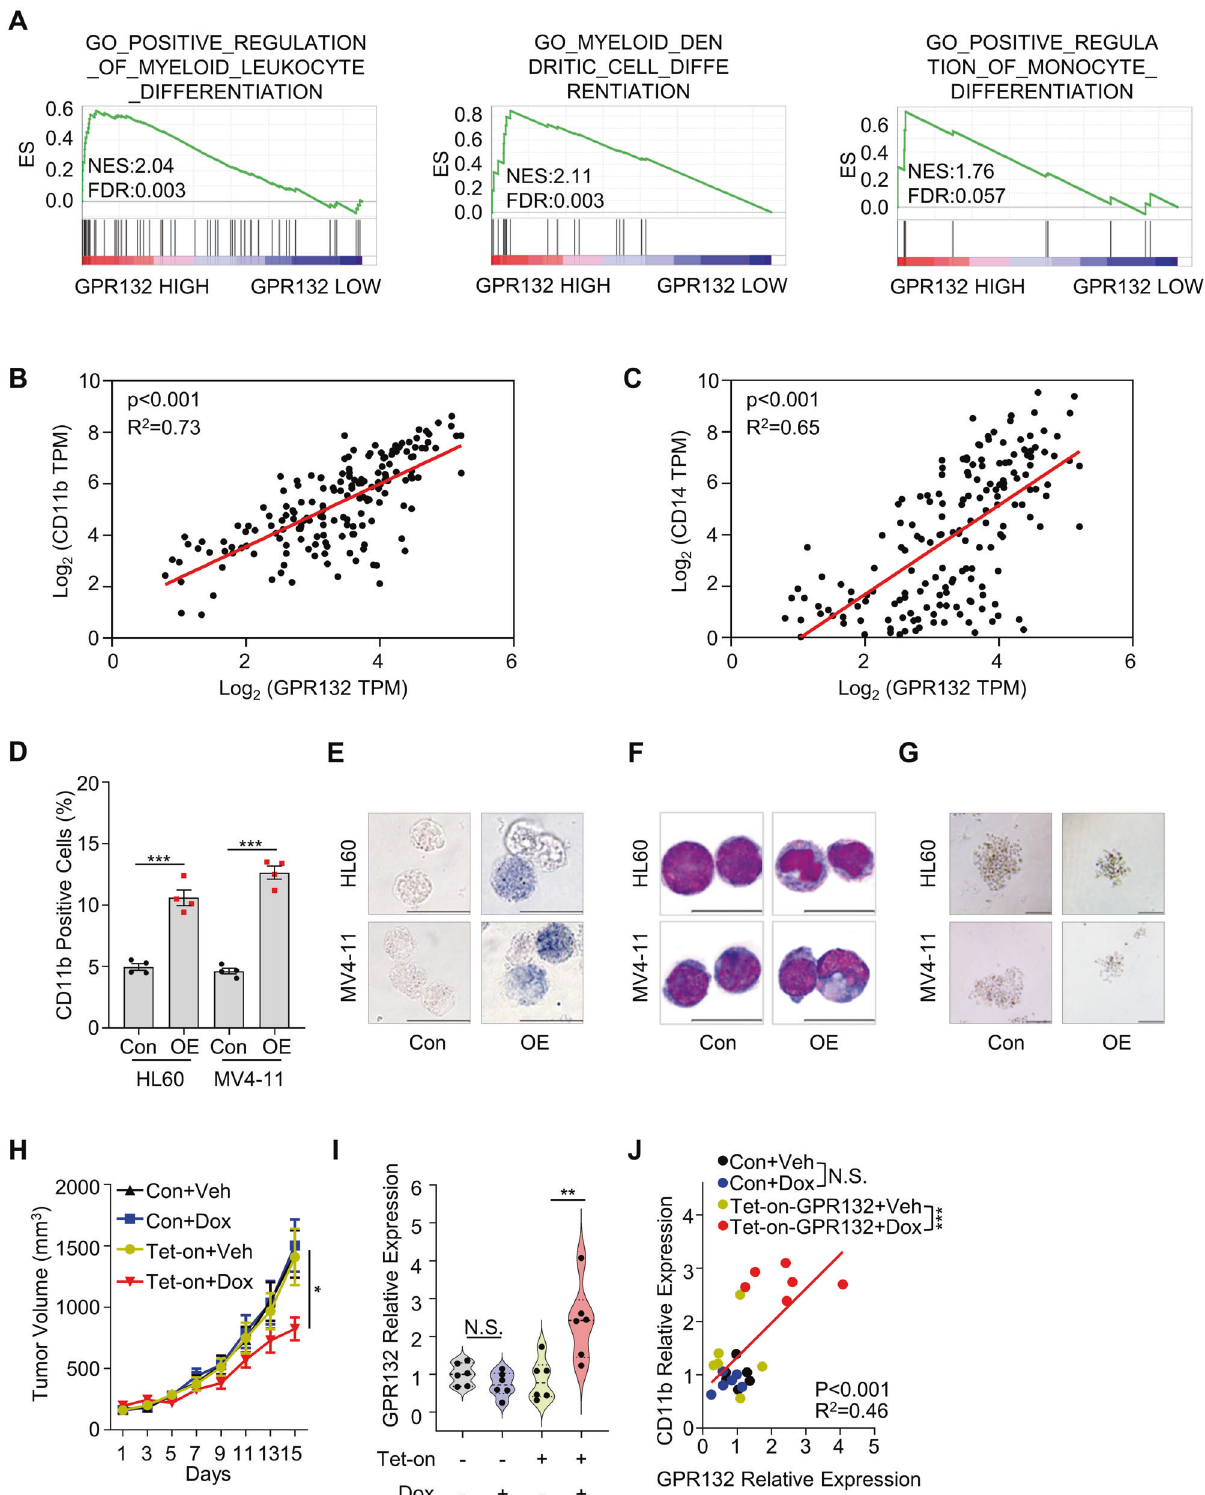
con fi rmed the positive correlation between GPR132 and